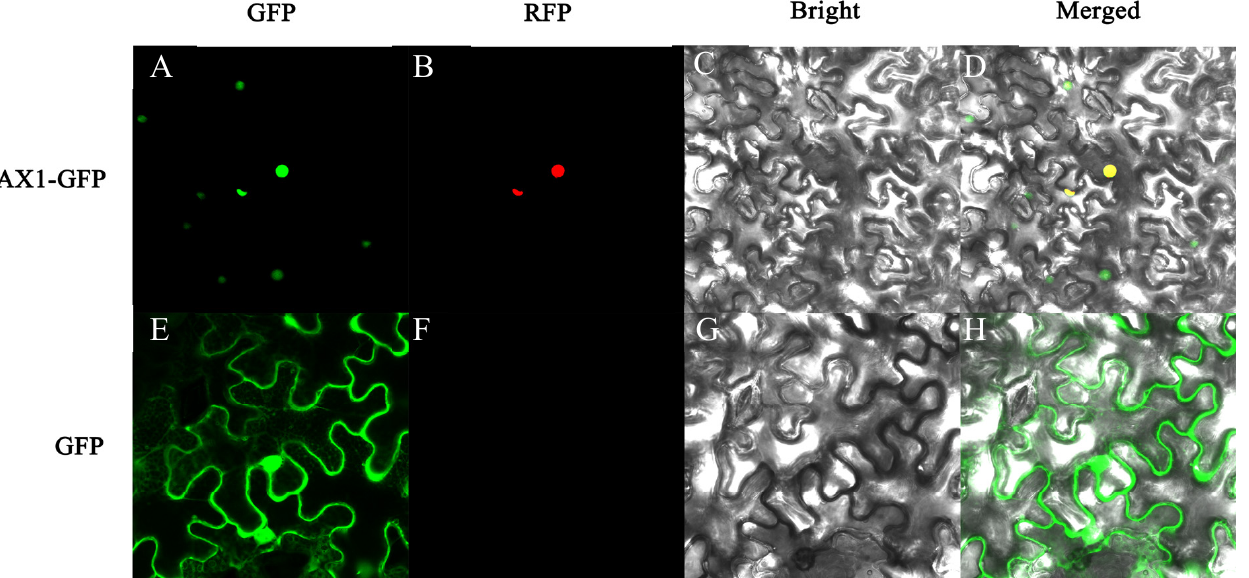
Figure 5. Subcellular localization of PhMYB37 in tobacco leaf epidermal cells. ( A , E ) Green fluores- cence images of PhMYB37-GFP protein and GFP (control). ( B , F ) Red fluorescence image of marker for nucleus localization. ( C , G ) Bright-field images of PhMYB37-GFP protein and control. ( D , H ) The merged images of PhMYB37-GFP protein and control.